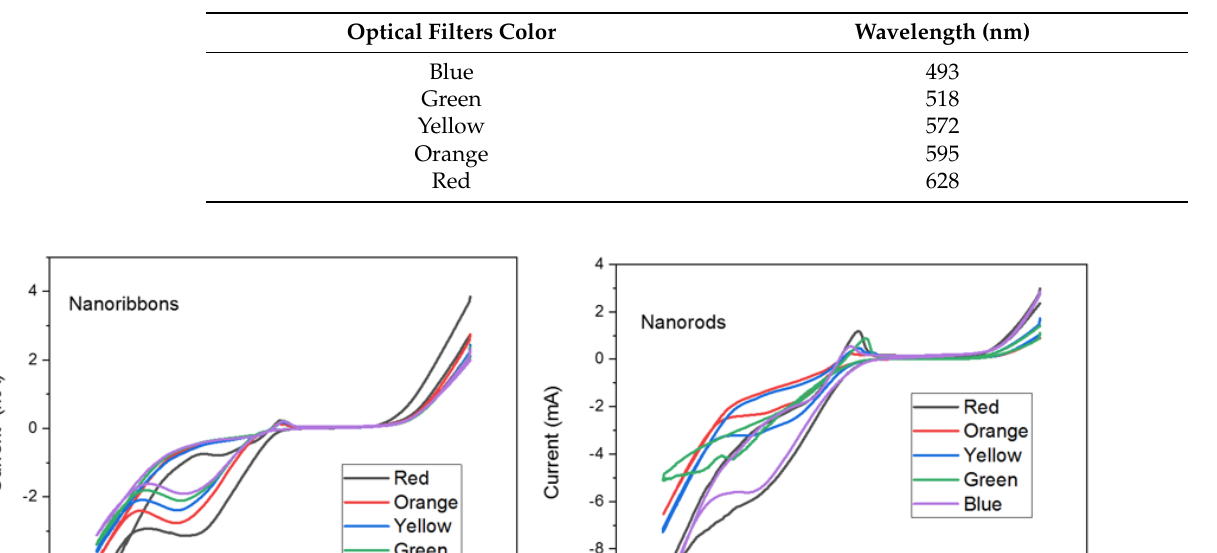
Table 1. Wavelengths of optical filters.